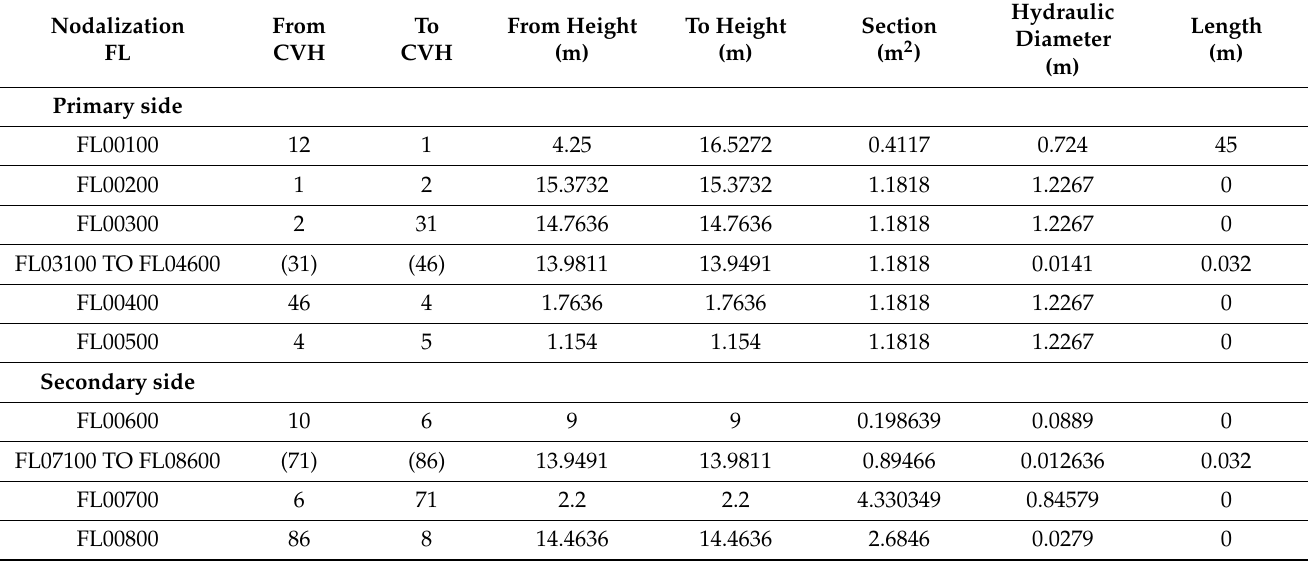
Table 12. FL number and